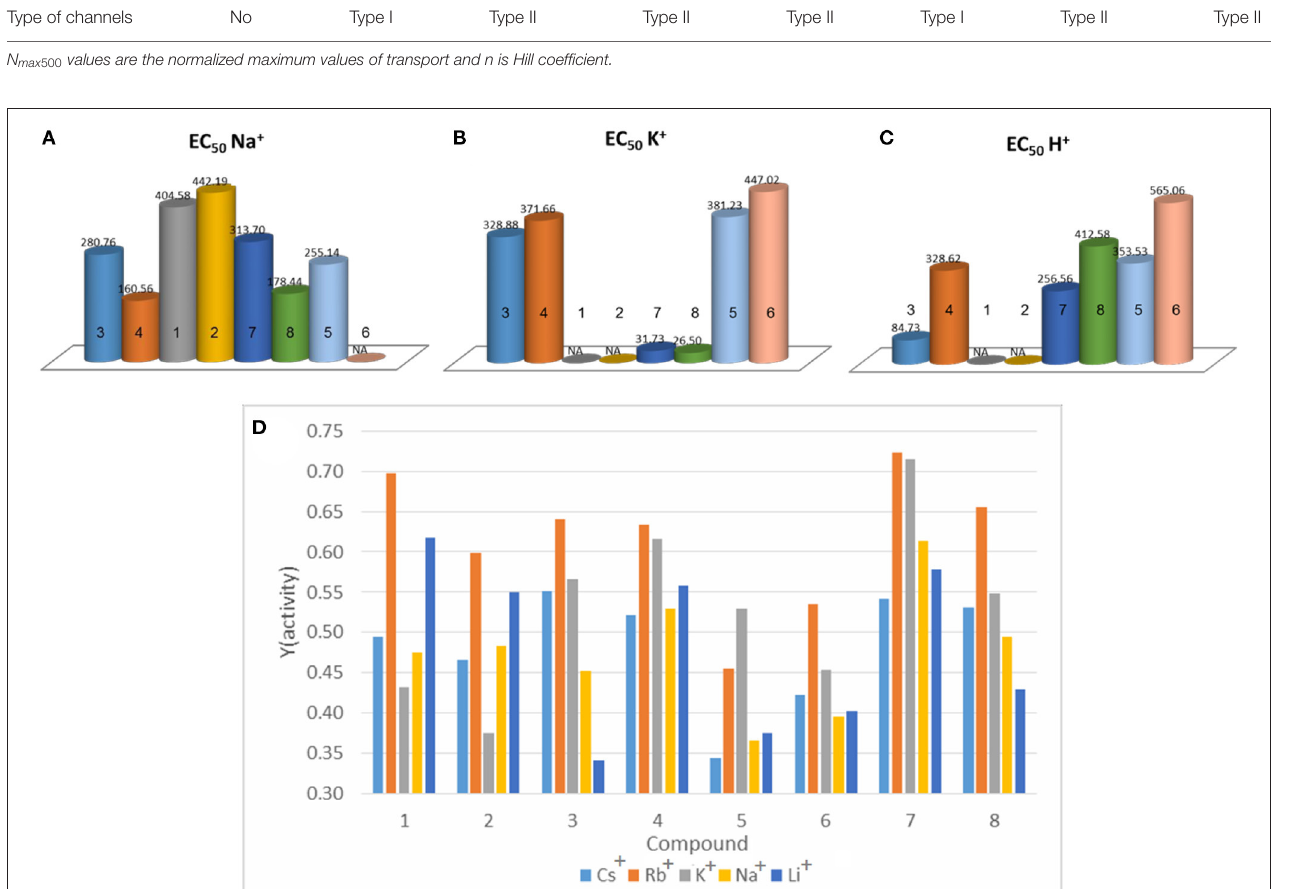
observation, the calculated values are similar to the experimental ones ( Supplementary Tables 2 , 3 ). By comparing the two values ( Supplementary Figure 6 ), the calculated one, based on the